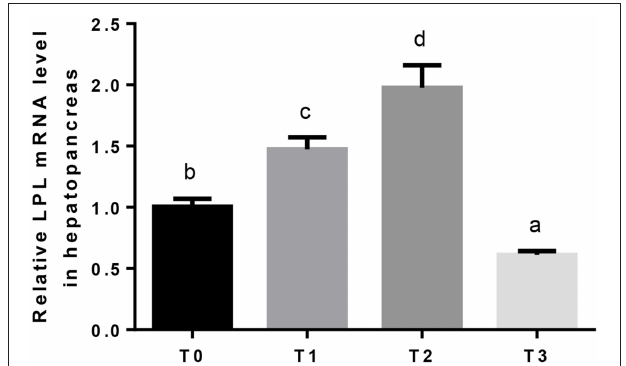
FIGURE 4 | The relative expression of LPL mRNA in the hepatopancreas. The letters indicate the results of multiple range test, the different letters indicated significant differences ( P < 0.05).